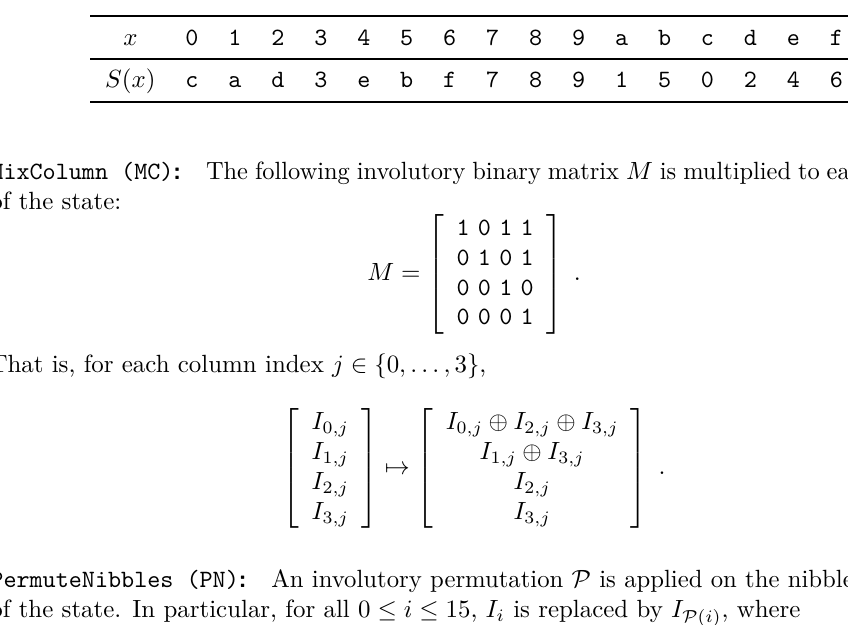
Figure 4: One full round function of CRAFT Table 1: The Sbox of MIDORI and